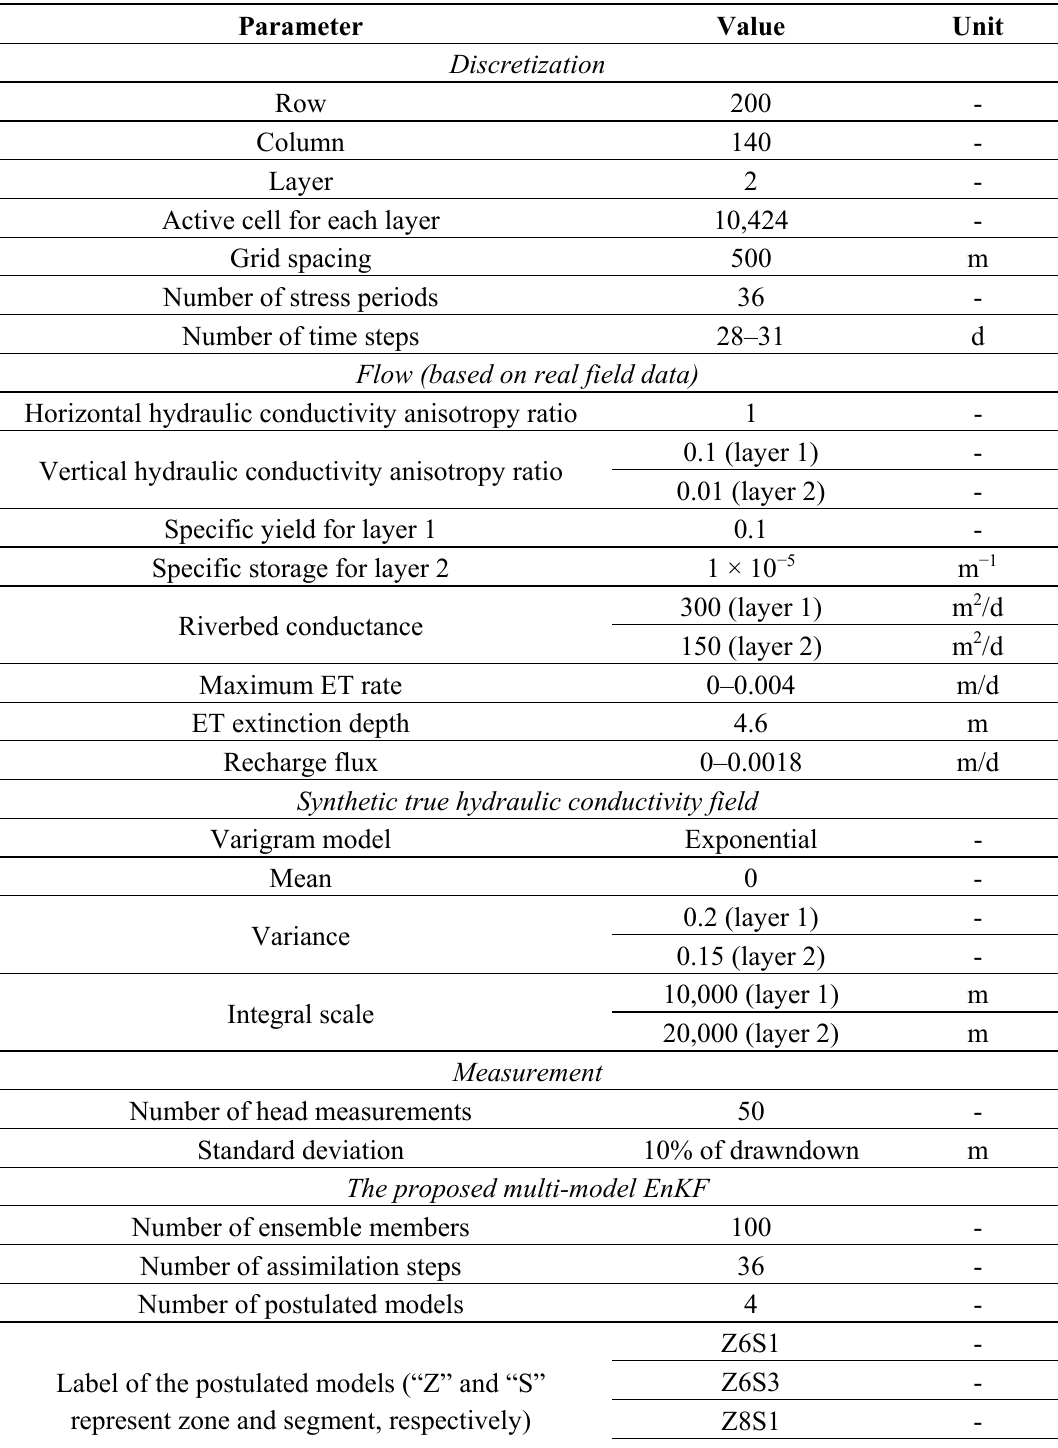
Table 3. Summary of the implementation